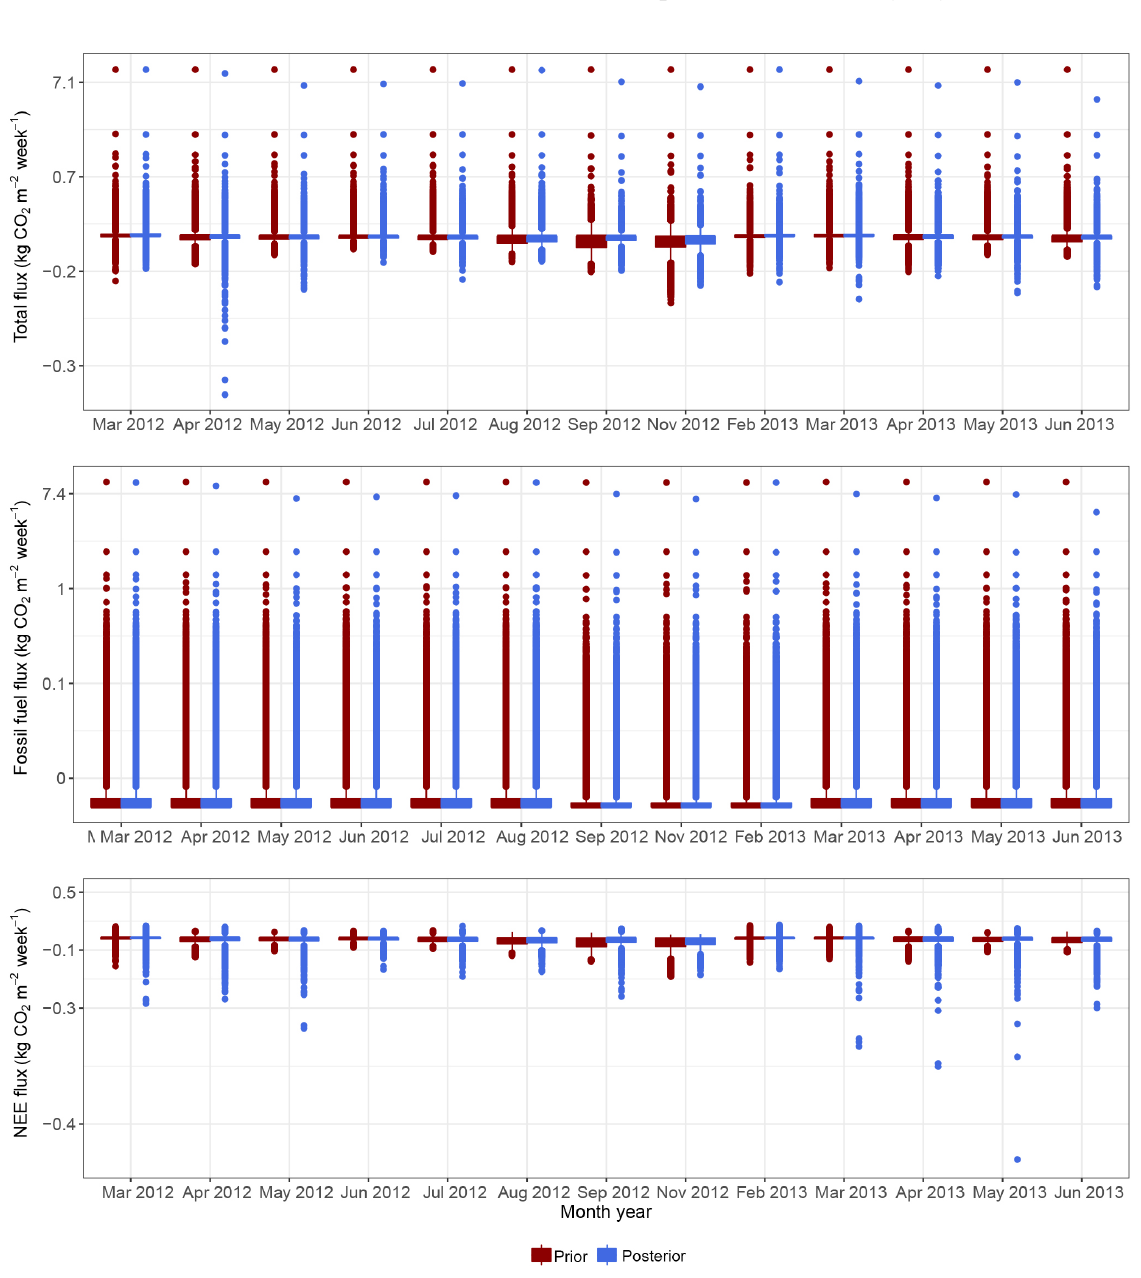
Figure 14. Box plots of the pixel-level weekly prior and posterior flux estimates (kg CO 2 m − 2 week − 1 ) for each month. These plots present summary statistics calculated over all pixels in the domain of the pixel-level mean weekly fluxes. The y axis is presented on a log